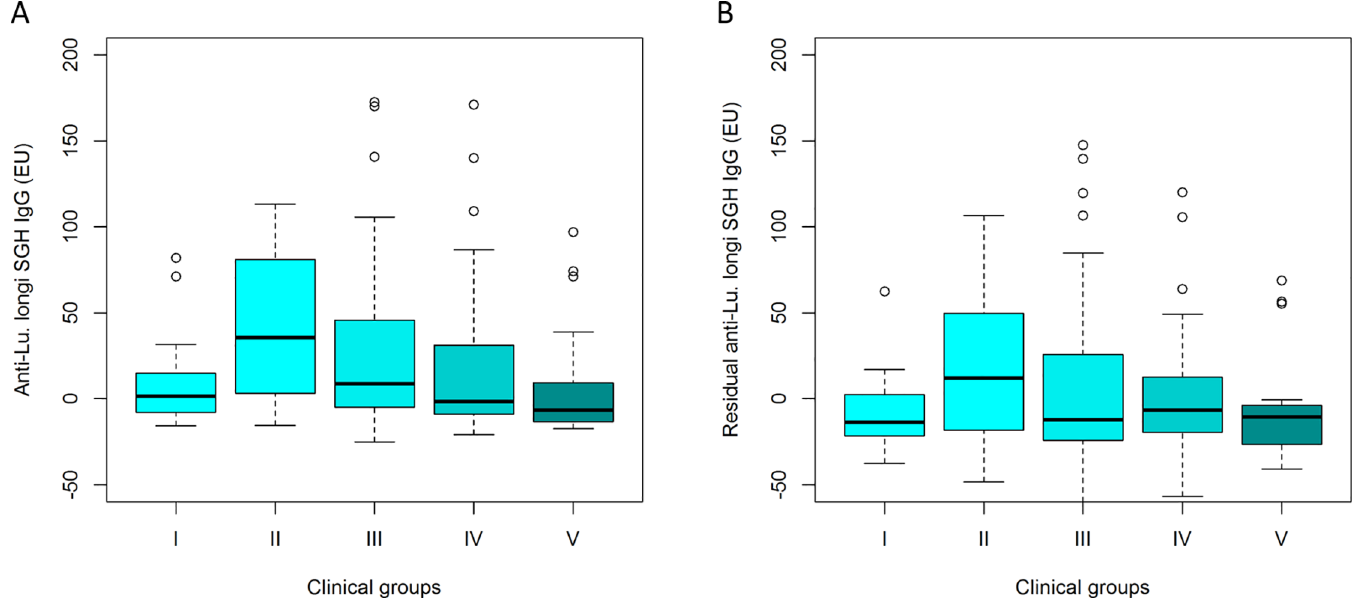
Fig 2. Anti- Lu . longipalpis SGH IgG levels (ELISA Units) in the sera of dogs relative to the clinical response. IgG levels were measured by ELISA. I—uninfected dogs, II—exposed dogs, III—infected dogs, IV—diseased dogs and V—severely diseased dogs. Anti–SGH IgG levels decreased with the severity of canine leishmaniasis before (A) and after (B) adjustment in the linear regression model (residual). The phenotypic variation of anti-SGH IgG levels was maintained after adjustment.